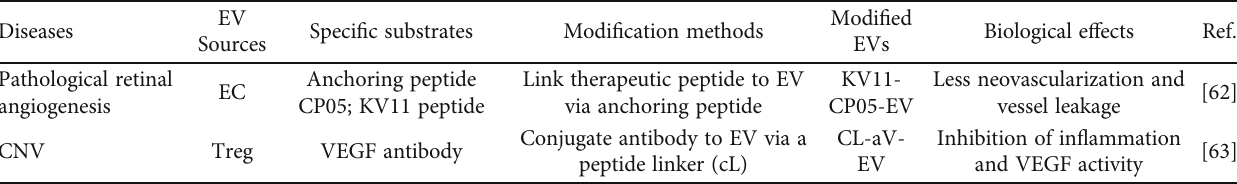
Table 2: Modi fi ed EVs in the therapy eye-related diseases.